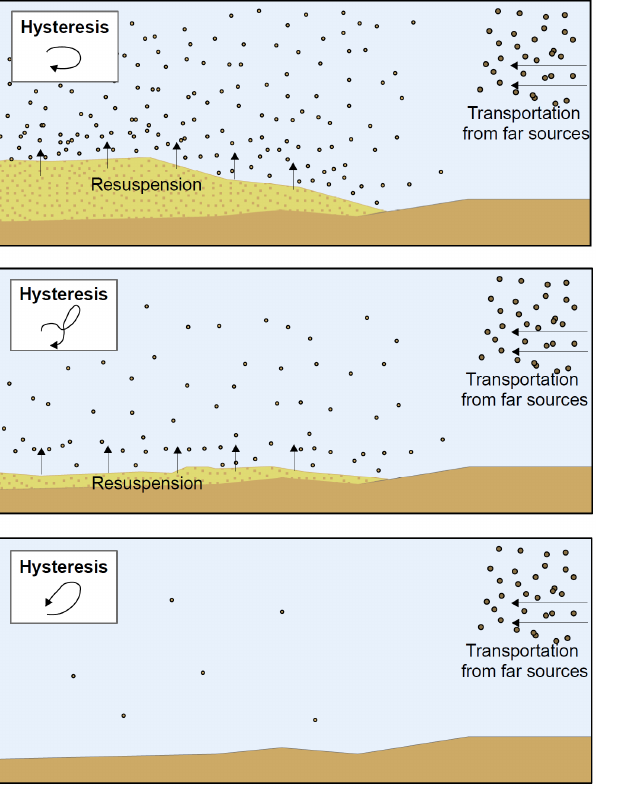
Figure 8. Schematic representation of suspended sediment dynam- ics in tidal rivers associated with the different types of hysteresis (clockwise, mixed and counterclockwise) during river